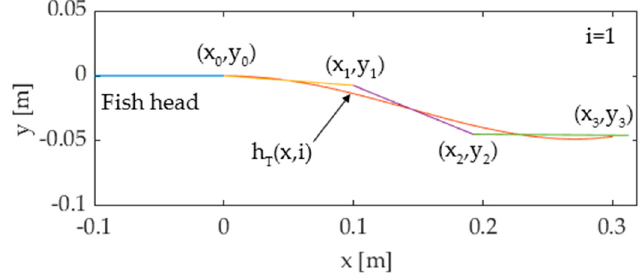
Figure 5. Tail posture approximated by the pose of a three-joint serial mechanism.